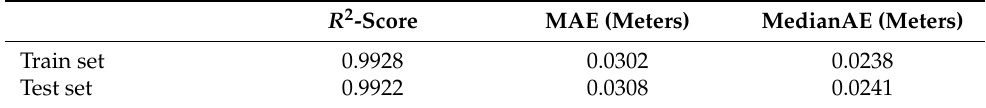
Table 2. Neural Network training results.